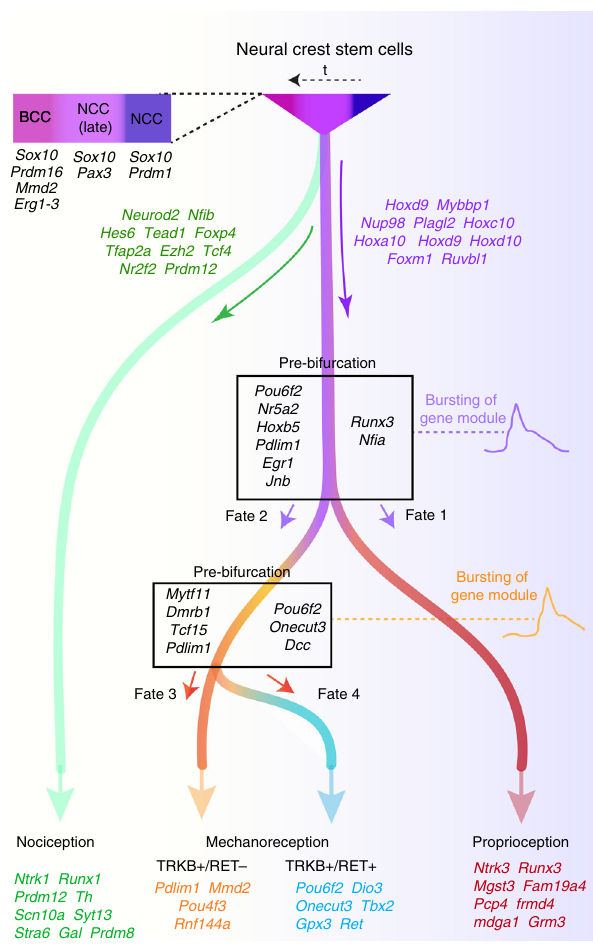
Fig. 7 Schematic representation of the fi ndings. Schematic representation of the neurogenesis from different stages of NCCs via distinct trajectories for the neurons of the unmyelinated (nociceptive) versus myelinated (tactile mechanoreceptive and proprioceptive) lineages of our dataset. The genes predicted to be involved in the unfolding of the trajectories are represented at the starting point of the trajectories, while genes that de fi ne the latter stage of maturation in our dataset are represented on the endpoints of the trajectories. Note the distribution of some members of the PRDM family (putative histone methyltransferases) throughout the tree. From the trajectory leading to tactile mechanoreceptor and proprioceptive neurons, bursting of genes of competing genetic programs prior to binary fate decision during sensory neuron diversi fi cation is reported at the pre-bifurcation level. Those genetic programs direct towards either speci fi c neuronal